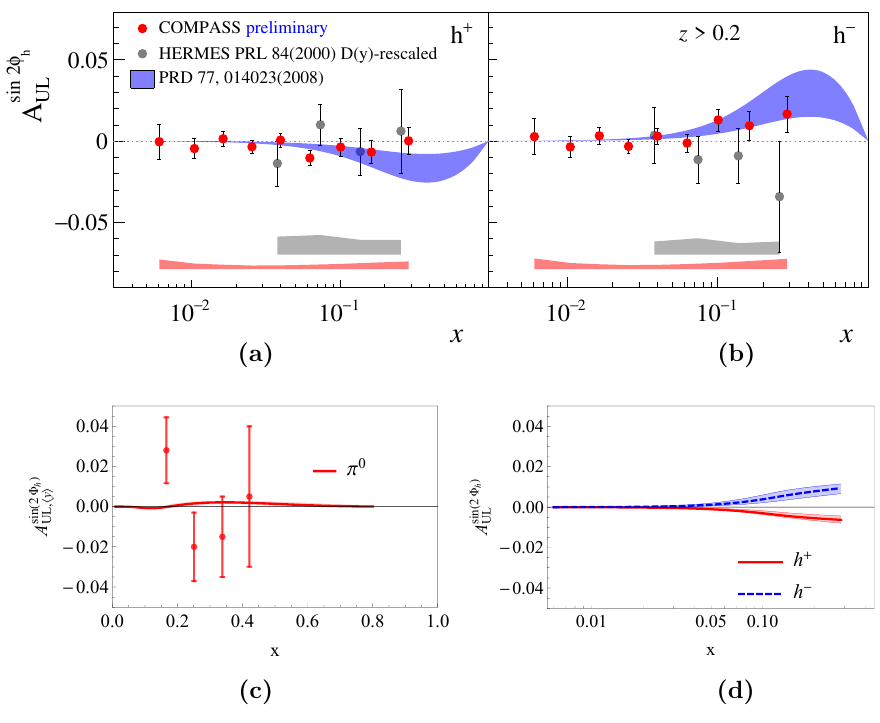
Figure 12. Leading twist A sin(2 (cid:30) h ) vs. x from HERMES [179] and COMPASS [176, 180] (a, b), UL A sin(2 (cid:30) h ) from JLab [181] (c), and from our calculation for COMPASS kinematics in the WW- UL; h y i type approximation (d) shown separately for reasons explained in the caption of (cid:12)gure 9. Results from [29] are also shown in comparison to the COMPASS